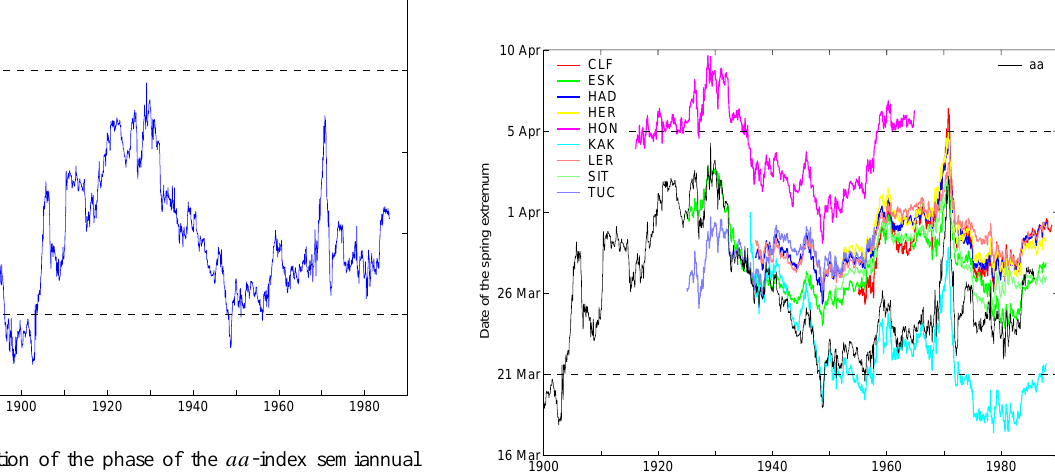
Fig. 4. Time variation of the amplitude of the semiannual varia- tion of the X -component in nine observatories (left ordinate axis), computed using a 22-year sliding window, centered. The sunspot number (right ordinate axis) and the amplitude of the semiannual variation of the aa -index (left ordinate axis), computed using the same window, are also represented.